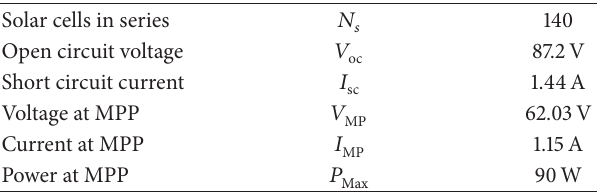
Table 3: CSSS-90A electrical specifications at standard testing